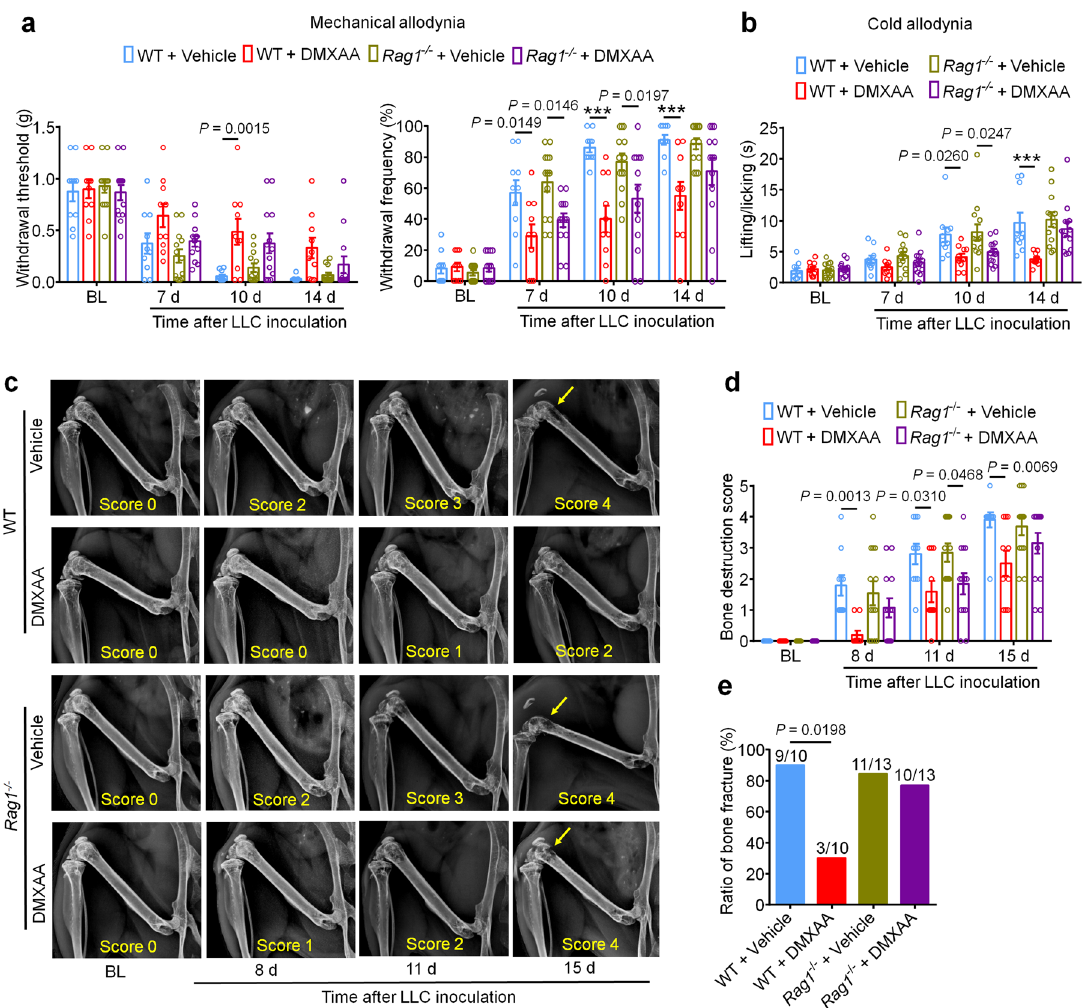
Fig. 8 The analgesic and bone-protective effects of STING agonists largely retain in T cell-de fi cient Rag1 − / − mice. a Mechanical allodynia from von Frey test in WT or Rag1 − / − mice treated with vehicle or DMXAA (2 × 20 mg/kg, i.p.) on baseline (BL), day 7, 10 and 14 after tumor inoculation. Left, withdrawal threshold. Right, withdrawal frequency, *** P < 0.001. b Cold allodynia from acetone test in WT or Rag1 − / − mice with indicated therapy, *** P < 0.001. c , d Radiographical analysis of bone destruction in WT or Rag1 − / − mice administered vehicle or DMXAA, measured at BL, d8, d11 and d15 post LLC inoculation. c Representative X-ray images. Bone destruction score is labeled on the bottom of each photo and arrows indicate bone destruction scores of more than 3. d Quanti fi cation for ( c ). e Quanti fi cation of the proportion of mice with distal bone fractures, harvested and analyzed at d17 post-inoculation and with the indicated genotypes and treatment groups. Sample sizes for a – e were as follows: n = 10 vehicle-treated WT mice, n = 10 DMXAA-treated WT mice, n = 13 vehicle-treated Rag1 − / − mice, and n = 13 DMXAA-treated Rag1 − / − mice (pooled from two independent experiments). Data are Mean ± SEM, repeated-measures two-way ANOVA with Bonferroni ’ s post hoc test ( a , b , d ); two-sided Fisher ’ s exact test ( e ). Source data are provided as a Source Data fi